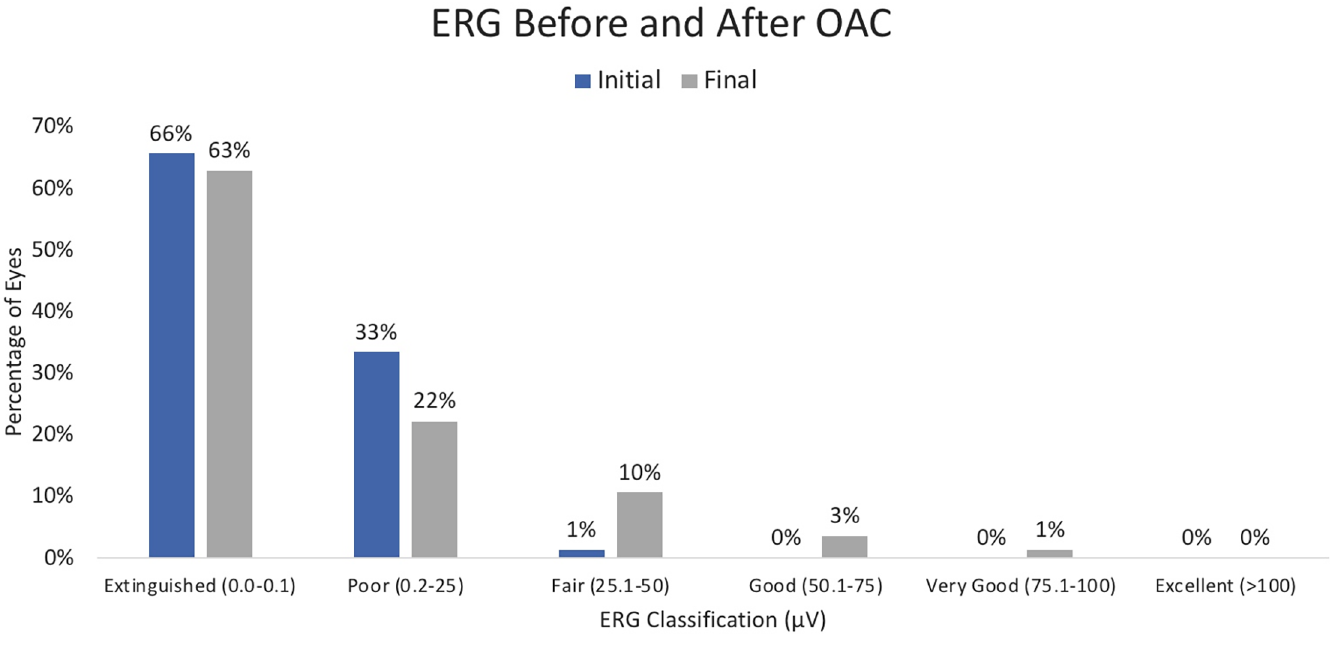
Fig 3. Electroretinogram (ERG) improvement after